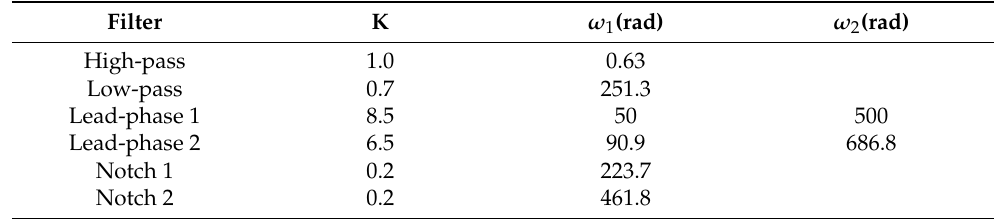
Table 1. Filters